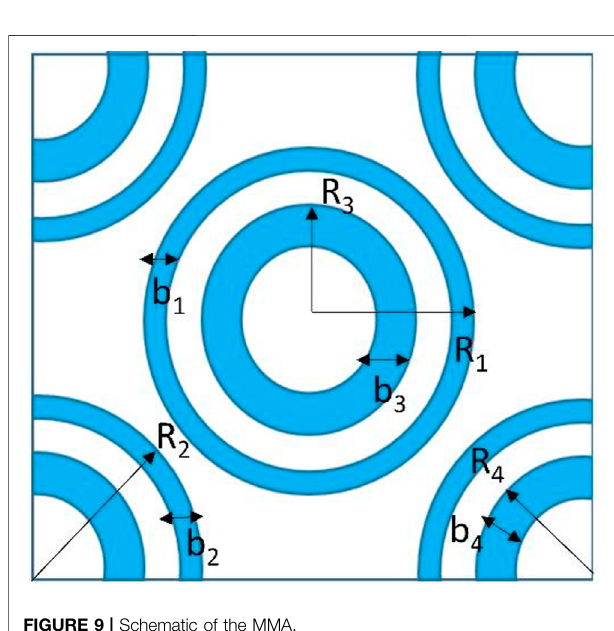
FIGURE 9 | Schematic of the